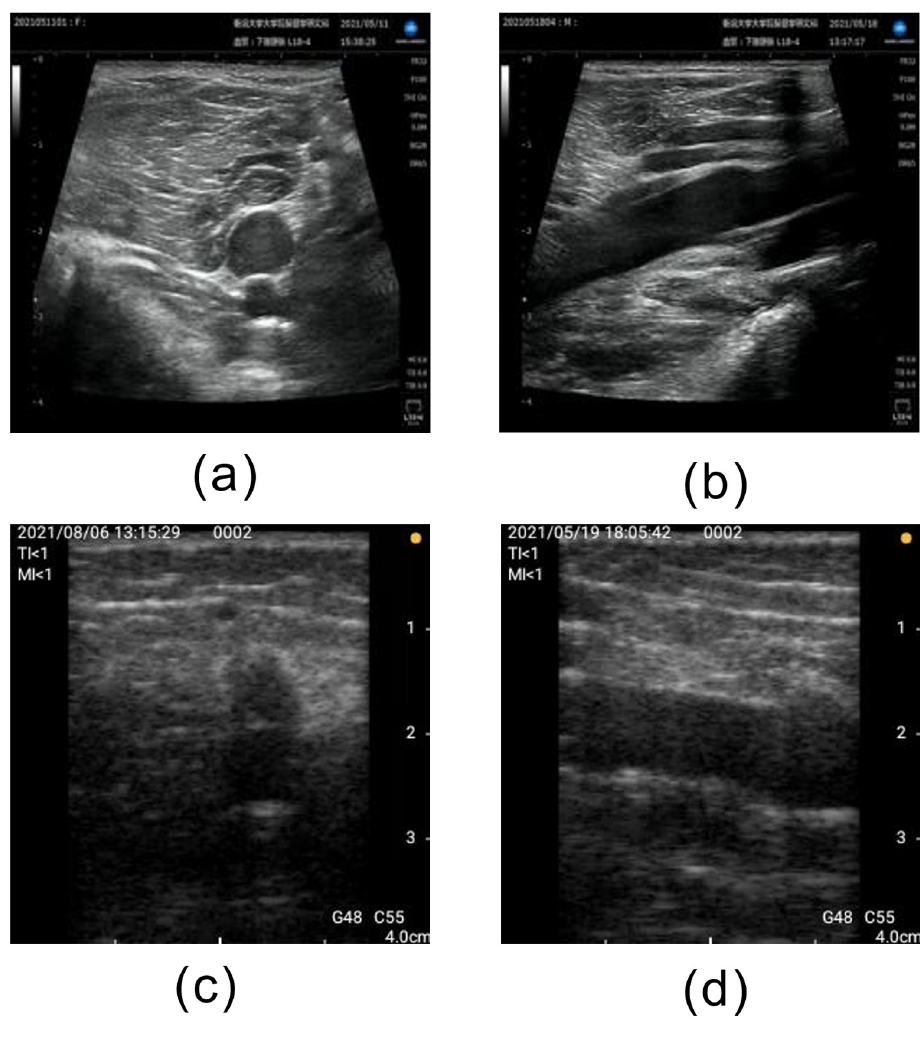
Fig 6. Examples of correctly classified satisfactory images. (a) Short axis acquired by stationary ultrasonography equipment, (b) Long axis acquired by stationary ultrasonography equipment, (c) Short axis acquired by portable ultrasonography equipment, and (d) Long axis acquired by portable ultrasonography